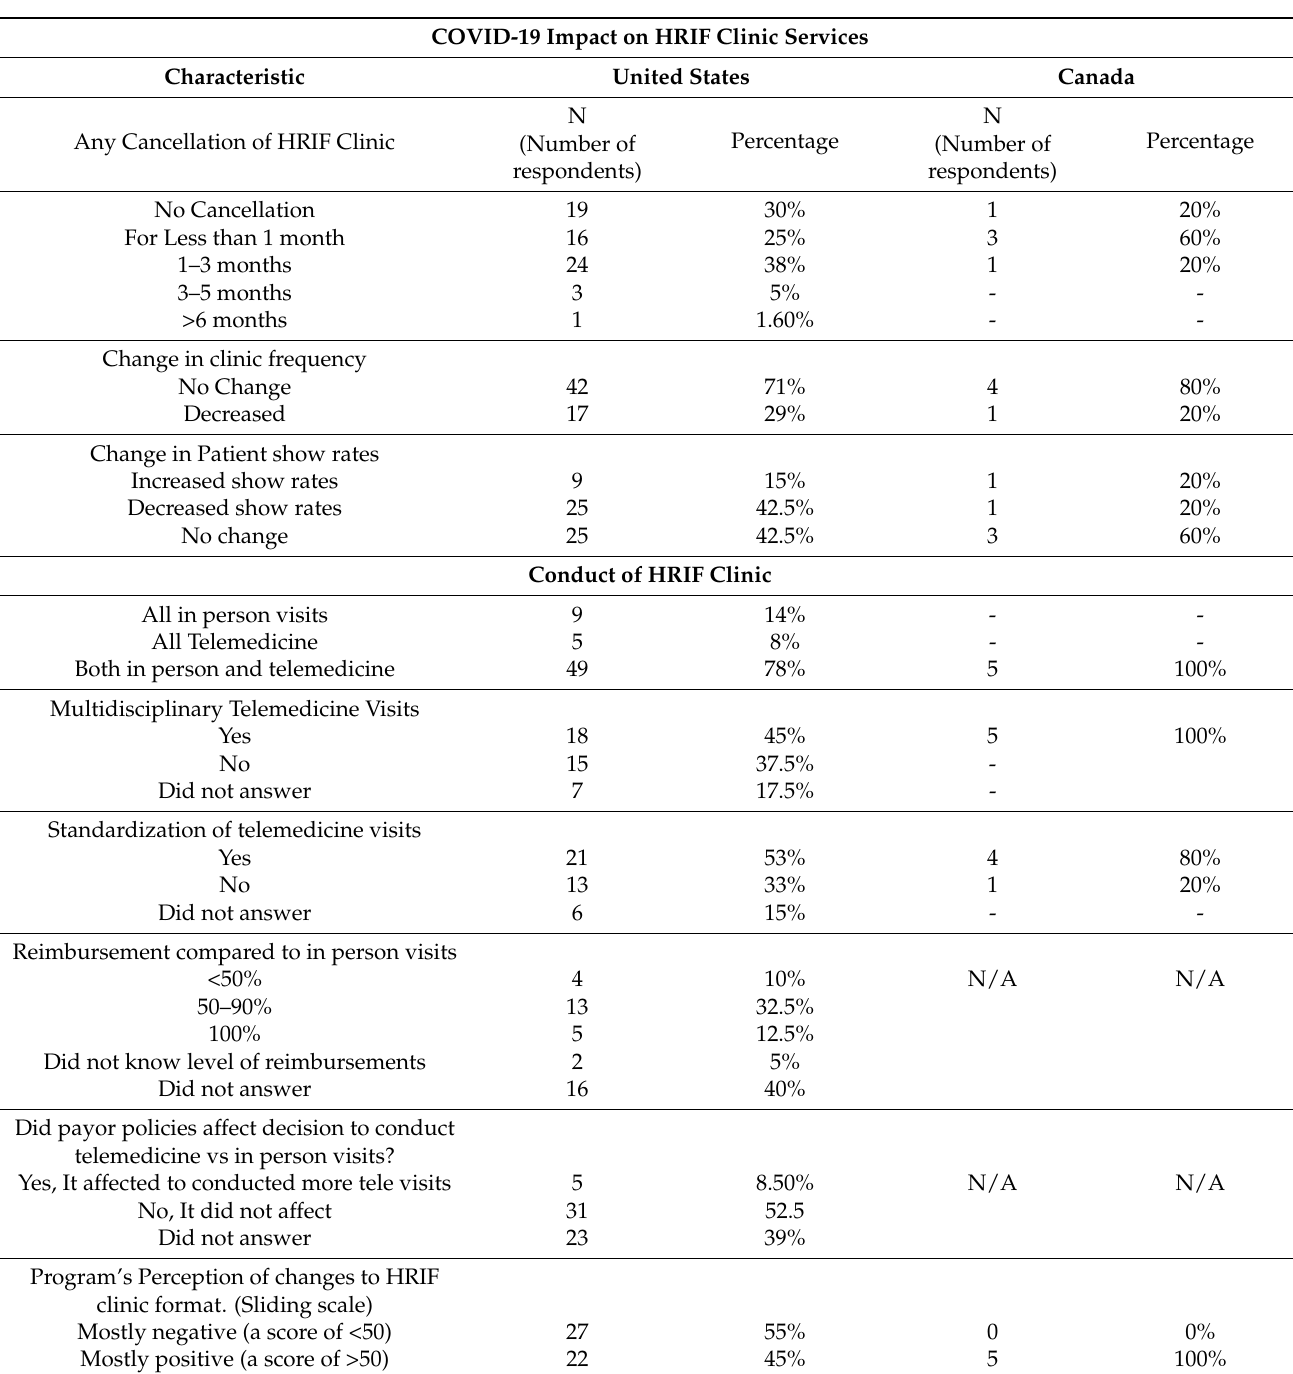
Table 2. Impact of COVID-19 Pandemic on HRIF Program